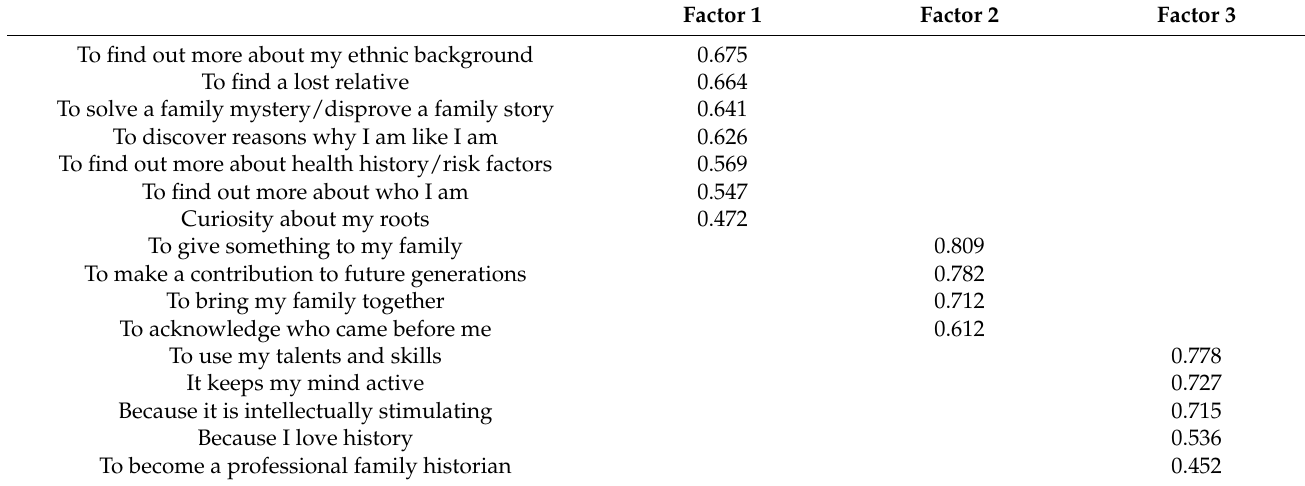
Table 2. Rotated component matrix for factor analysis of the Psychosocial Motivations for Family History Research Scale. Factor 1 Factor 2 Factor 3 To find out more about my ethnic